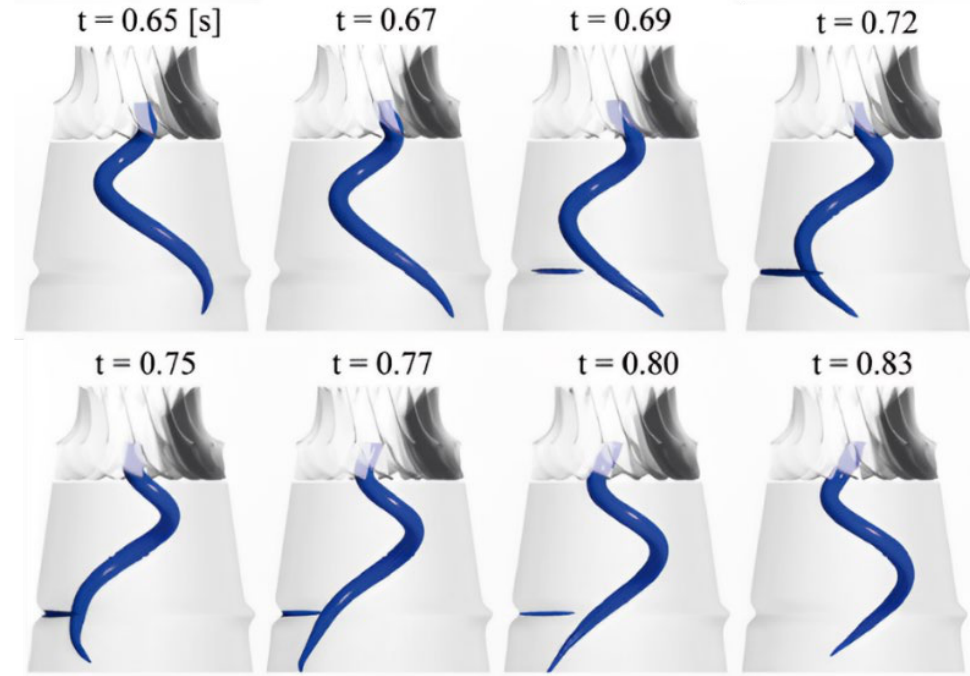
Figure 3. Schematic diagram of vortex rope evolution [18].